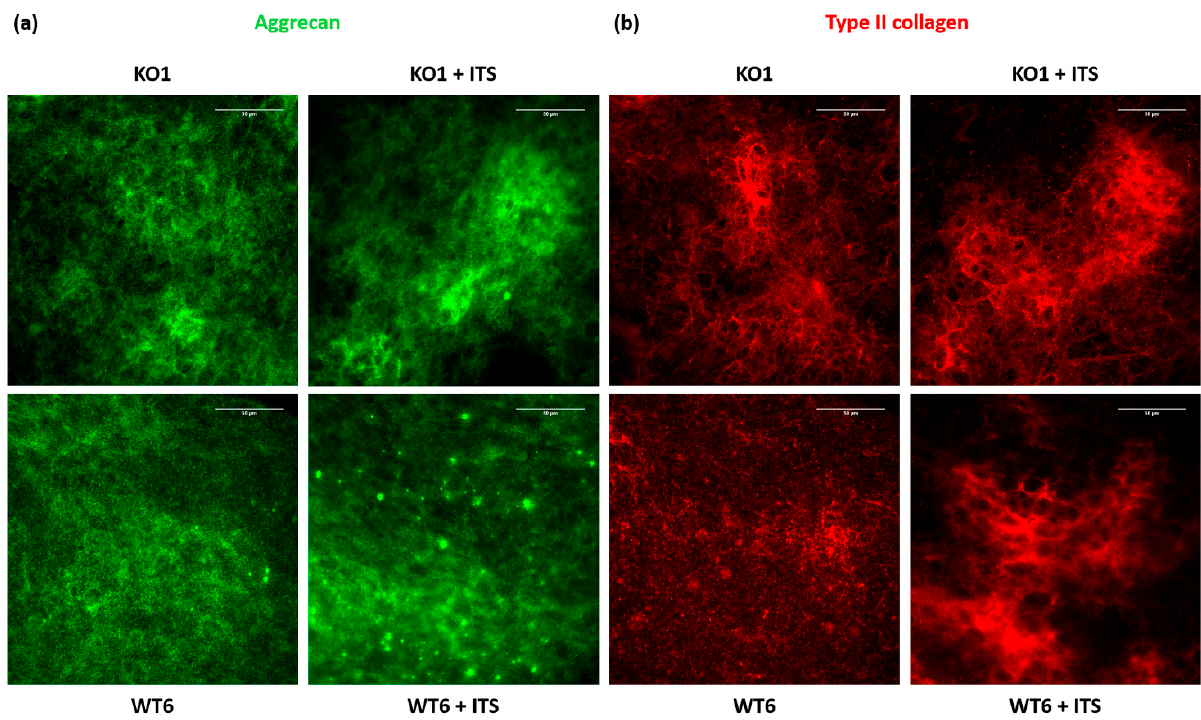
Figure 6. Immunofluorescence study of the extracellular matrix produced by immortalized chondrocytes incubated with or without ITS for 12 days. ( a ) Immunofluorescence analysis with a specific antibody against aggrecan. ( b ) Immunofluorescence analysis with a specific antibody against type II collagen. Both aggrecan and type II collagen showed an increased deposition and a better-defined network in immortalized chondrocytes, both Cant1 knock-out (KO1) and wild-type (WT6), after incubation with ITS. Scale bar 50 µm.